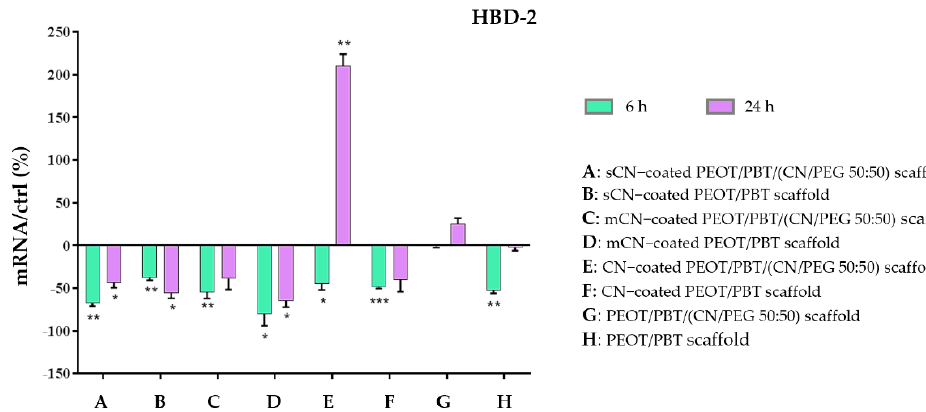
Figure 8. Bar graph showing the results of RT-PCR analysis for HBD-2 produced by HaCaT cells exposed for 6 h and 24 h to PEOT/PBT scaffolds, and PEOT/PBT/(CN/PEG 50:50) scaffolds, coated with electrosprayed CNs from different sources. The results were reported as percentage (%) normalized by the basal expression of those cytokines in untreated cells as control (ctrl). Data are expressed as mean ± standard deviation with respect to ctrl ( n = 3; * p < 0.05; ** p < 0.01; *** p < 0.001).